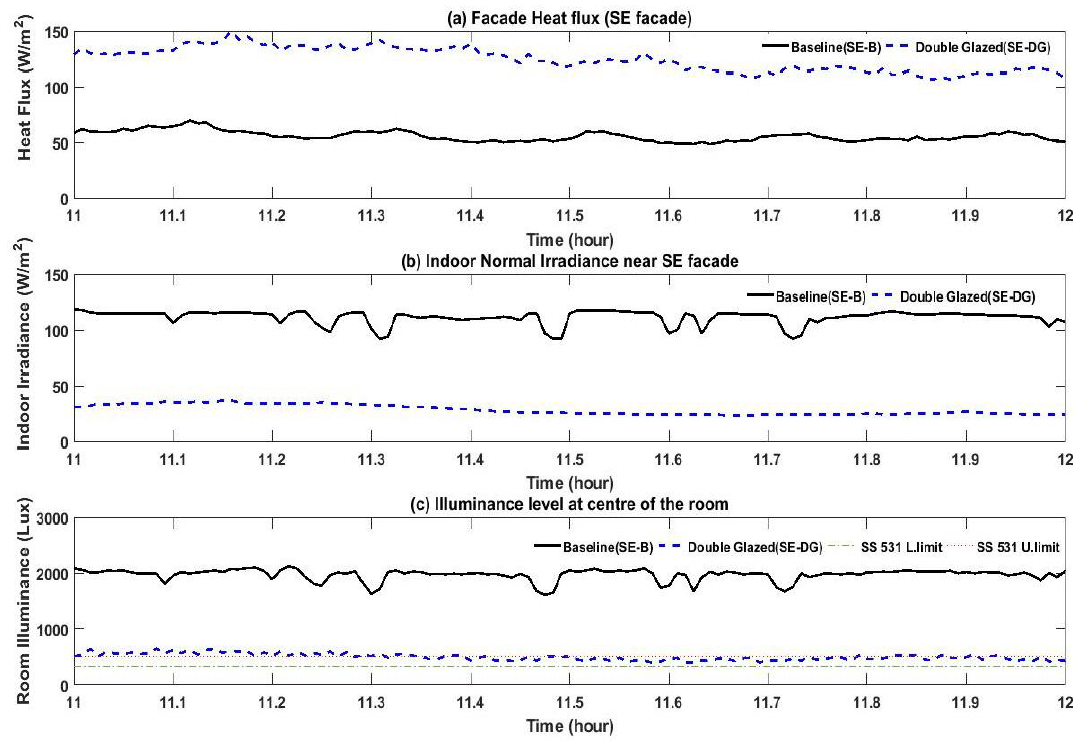
Figure 4. Comparative plots before and after retrofit double glazing of SE façade: ( a ) Façade heat flux; ( b ) indoor normal irradiance; ( c ) illuminance level at room center.